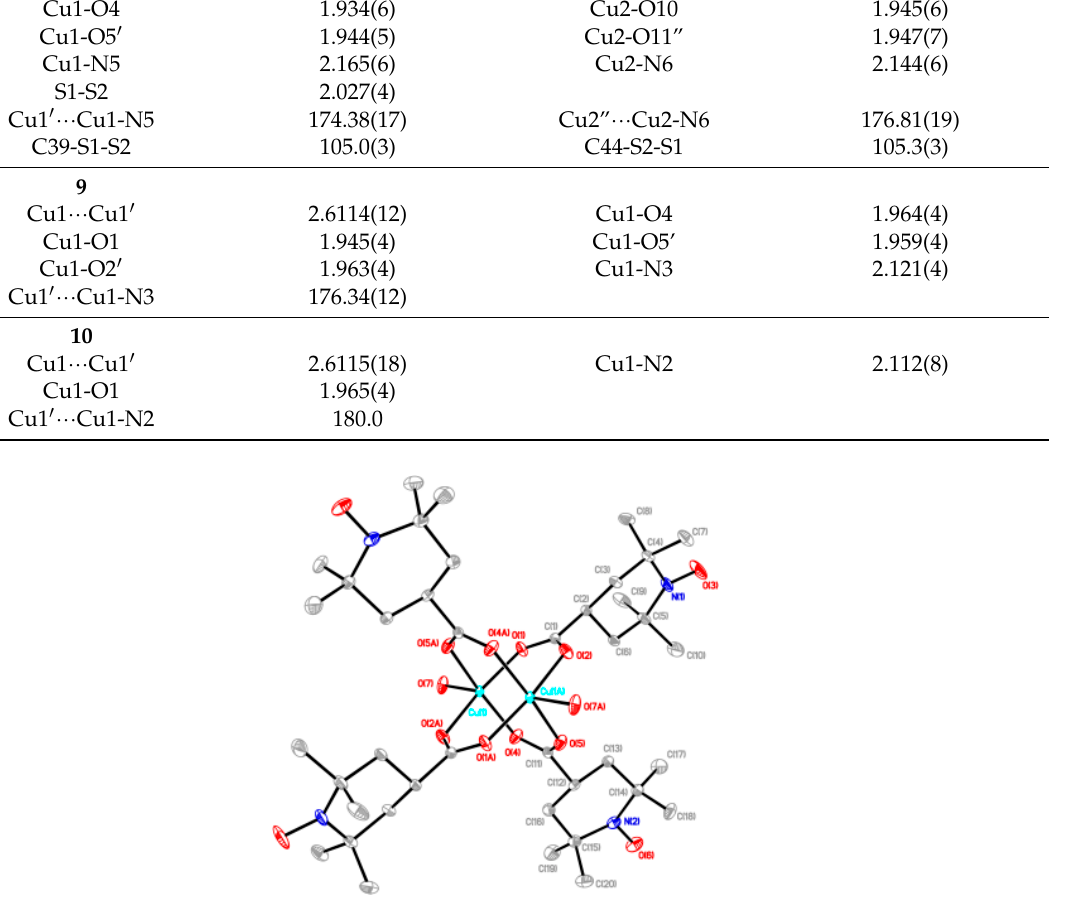
Figure 5. Perspective view of [Cu 2 (catempo) 4 (H 2 O) 2 ] ( 2 ). Hydrogen atoms are omitted for clarity.